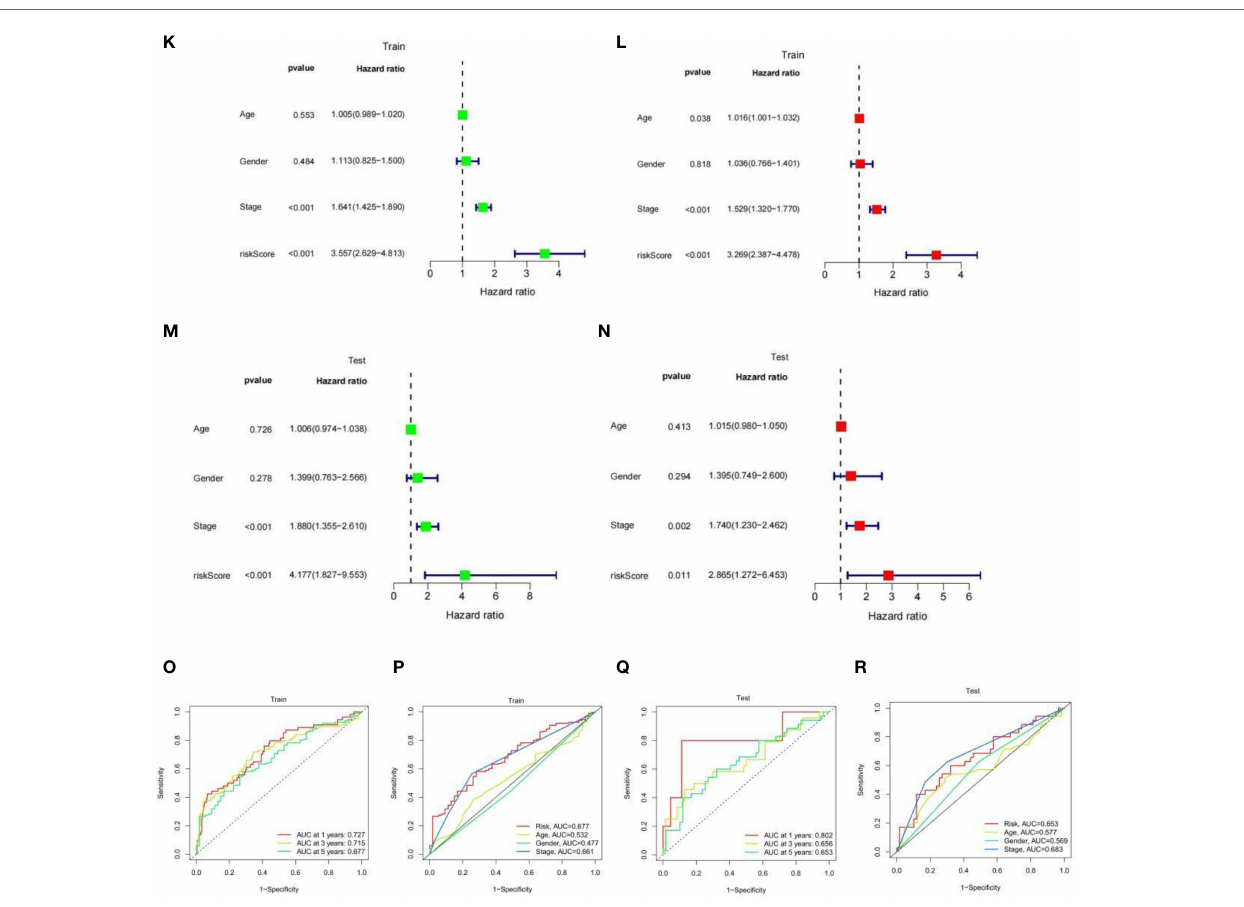
FIGURE 2 | (A) Univariate analysis of genes related to fatty acid metabolism. When the hazard ratio of a gene is >1, it indicates that the gene is a risk factor for the corresponding tumor, and vice versa. (B) Gene mutations in patients with TCGA-LUAD. (C) Correlation of mutations in 29 fatty acid metabolism genes. Brown color indicates negative correlation, and blue color indicates positive correlation. p < 0.05, *p < 0.01. (D) LASSO coef fi cient spectrum of 29 fatty acid metabolism genes. (E) Cross-validation of adjustment parameter selection in a proportional hazards model. (F) PCA based on all fatty acid metabolism-related genes in the TCGA-LUAD cohort. (G) PCA based on fatty acid metabolism risk scores in the TCGA-LUAD cohort. (H) PCA based on fatty acid metabolism risk scores in the GEO-LUAD cohort. The red group represents high-risk patients, and the blue group represents low-risk patients. (I) OS by fatty acid risk score in the TCGA-LUAD cohort. (J) OS by fatty acid risk score in the GEO-LUAD cohort. (K) Results of univariate Cox analysis in the TCGA-LUAD cohort. (L) Multivariate Cox analysis results in the TCGA-LUAD cohort. (M) Results of univariate Cox analysis in the GEO-LUAD cohort. (N) Multivariate Cox analysis results in the GEO-LUAD cohort. (O) AUC values at 1, 3, and 5 years in the TCGA-LUAD cohort. (P) ROC curves of risk scores and clinical characteristics in the TCGA-LUAD cohort. (Q) AUC values at 1, 3, and 5 years in the GEO-LUAD cohort. (R) ROC curves of risk scores and clinical characteristics in the GEO-LUAD